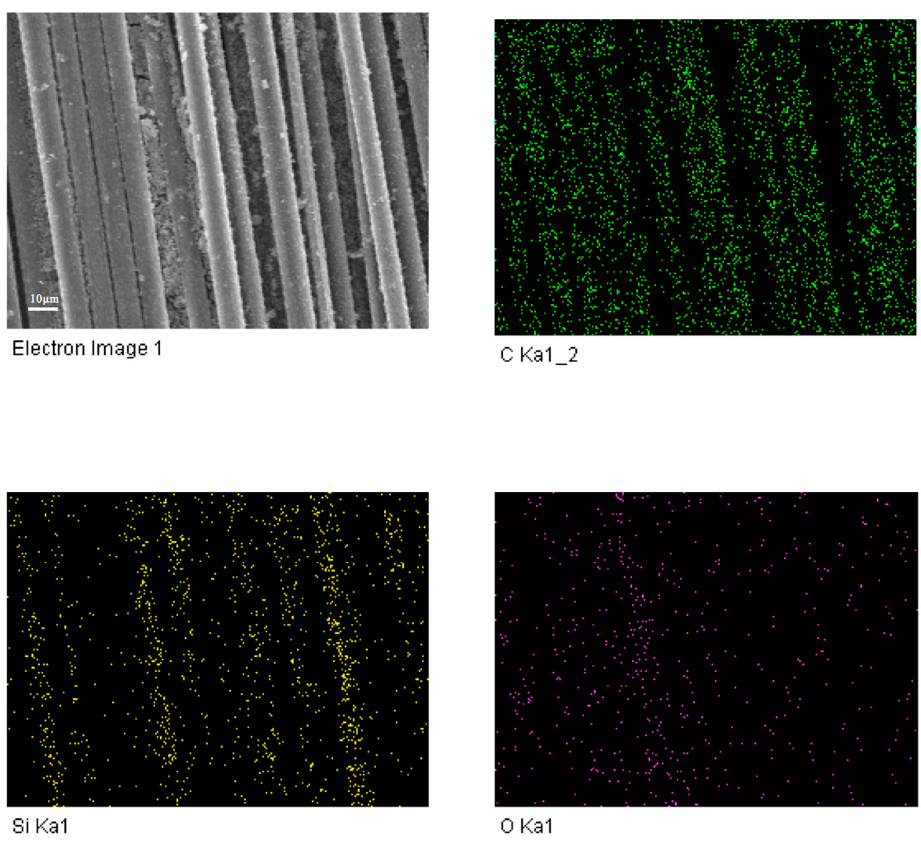
Figure 3. EDS analysis of SiC/SiO 2 coated CF. Scale bar represents 10 μ m.